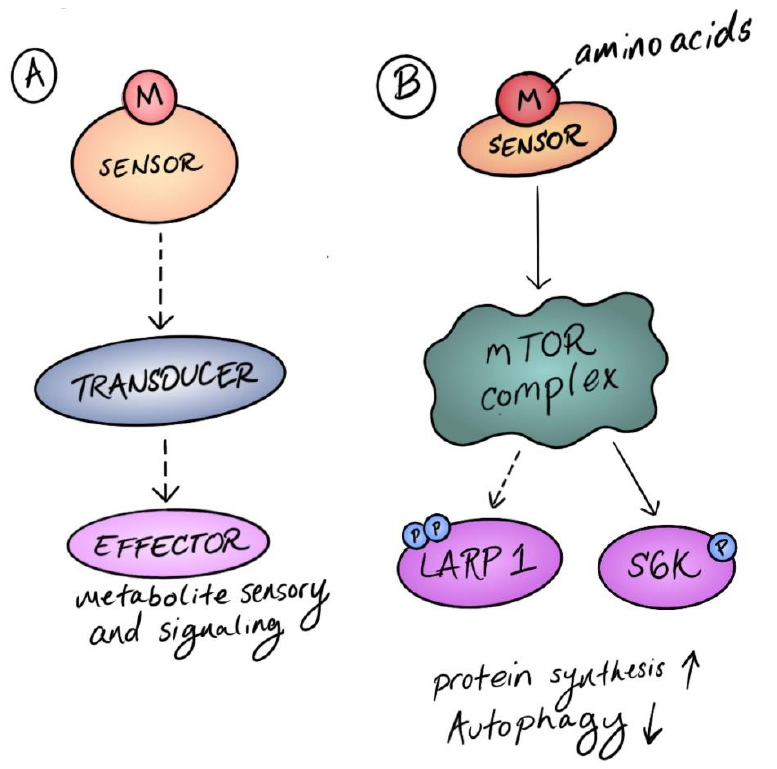
Figure 1. Sensors and transducers in metabolic signaling. ( A ) Metabolic signaling is triggered by a metabolite sensor protein that directly binds to a metabolite. The sensor then engages transducers in a signaling pathway that eventually activate responses through an effector protein. ( B ) In mammalian models, amino acids are sensed directly by diverse sensor proteins that activate the mechanistic target of rapamycin (mTOR), a central regulatory hub that transduces diverse upstream signals to coordinate metabolism. mTOR then phosphorylates additional transducers and effectors, such as LARP1 and S6K, to promote protein synthesis and repress autophagy.